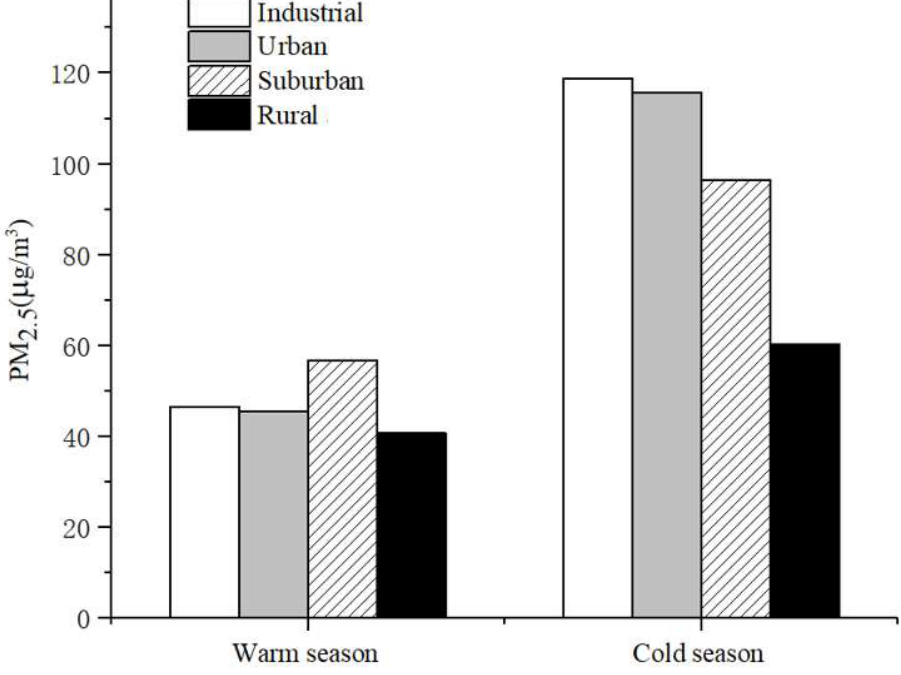
Figure 4. Comparison of average concentrations of PM 2.5 between the representative warm and cold seasons among four different functional regions in Nanjing city during 2016.